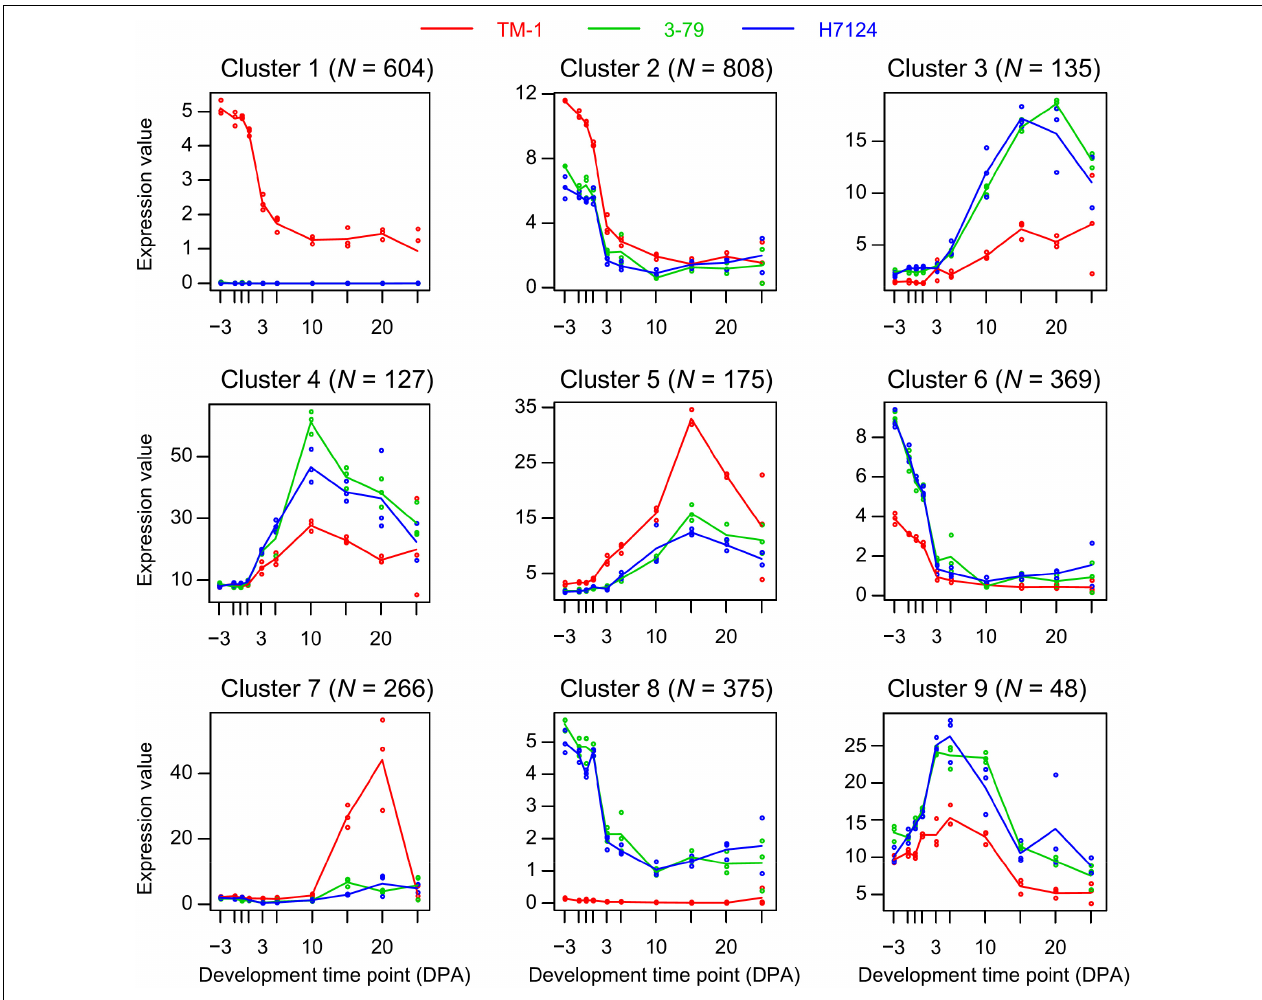
FIGURE 2 | Different gene expression patterns based on the time-course analysis. Each cluster represents a trend of gene expression and the number on top indicates the number of genes in cluster. Different colored curves represent cultivars and each curve represents the median profile of genes at different developmental time